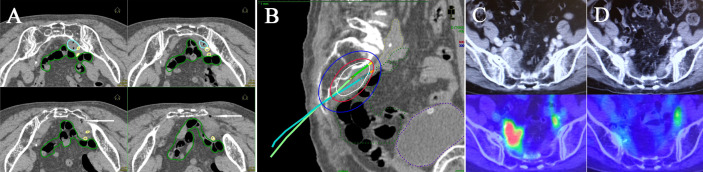
Multi-slice axial CT images (A) of implanted needles and a sagittal CT image (B) of the right internal iliac node (cyan dashed line), bowel (green dashed line), common/internal iliac vessels (yellow dashed line), and bladder (purple dashed line) receiving 50% (blue lines), 100% (red lines), and 150% (white lines) of the prescription dose (6 Gy) in a representative post-operative patient. Pre-treatment CT/18F-FDG-PET/CT images (C) and post-treatment CT/18F-FDG-PET/CT images (D). Both insertion points and directions were decided using pre-treatment CT. Two flexible interstitial needles (white arrows) were obliquely implanted in the prone position, passing from under the right sacroiliac joint through the front of the piriformis muscle up to the front of the second sacral vertebrae under CT guidance (no contrast medium) in the HDR room with dedicated CT. Implantation was performed under local anesthesia alone, with care taken not to damage the bowel or common/internal iliac vessels. The catheter was inserted into the central part of the node using an iterative approach of catheter implantation and adjustment with serial CT image acquisition. MPR CT was used to reconstruct the axial images into oblique anatomical planes. The patient was irradiated in the prone position in the HDR room with dedicated CT.